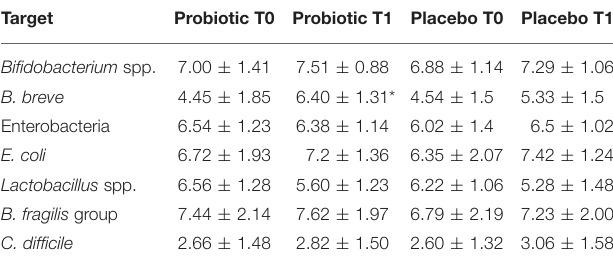
TABLE 4 | Mean counts (Log CFU/g of faeces) of different microbial groups analyzed in stool samples of the whole cohort. Target